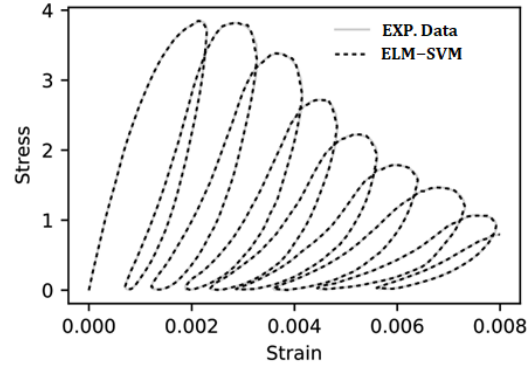
Figure 8. Experimental hysteresis loops [32] and the simulated loops by ELM − SVM model.